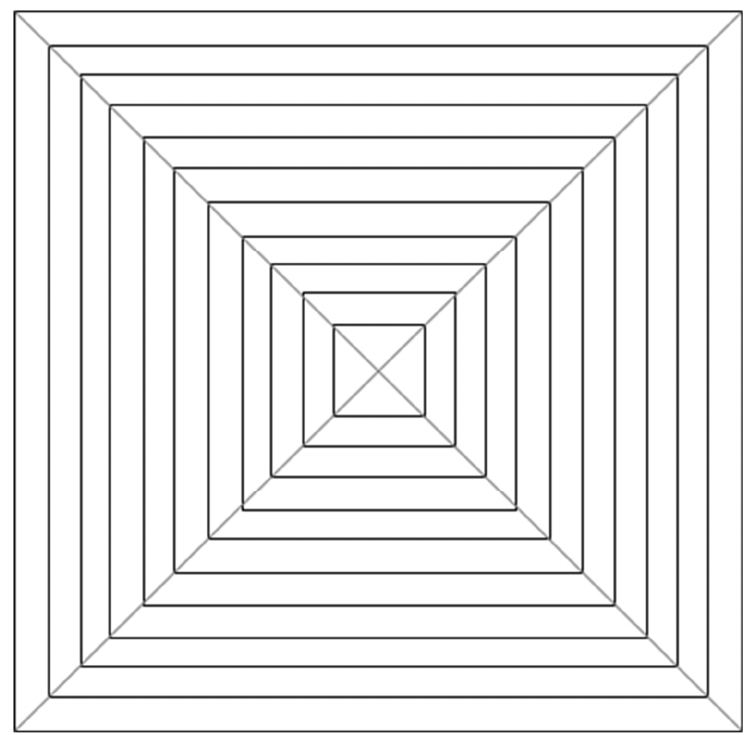
Figure 4. Schematic of experimental stimulus 4 (IN): INCOMPLETE (squares only) EQUIDISTANT “NO PERSPECTIVE” GRID.